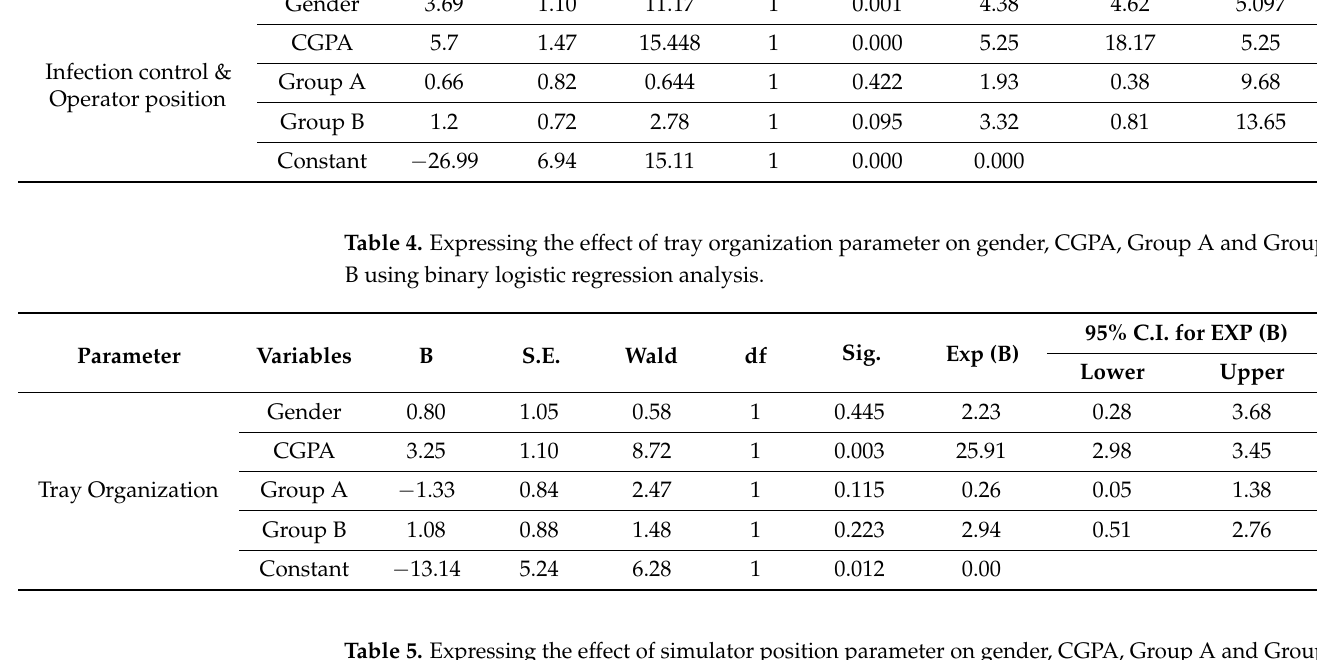
Table 5. Expressing the effect of simulator position parameter on gender, CGPA, Group A and Group B using binary logistic regression analysis.